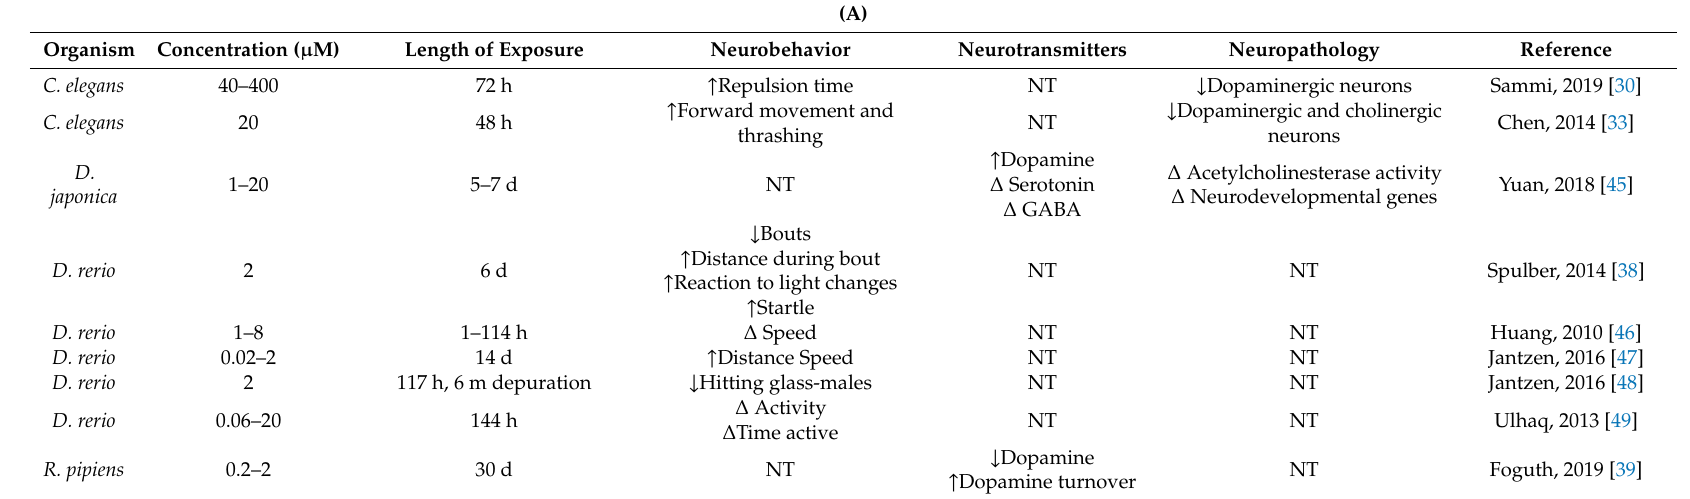
Table 2. Neurotoxicity endpoints and findings in species where neurological endpoints were tested. ( A ). PFOS neurotoxicity and findings in species where neurological endpoints were tested ( B ). PFNA neurotoxicity endpoints and findings in species where neurological endpoints were tested. NT = not tested ( C ). PFOA neurotoxicity endpoints and findings in species where neurological endpoints were tested. NT = not tested. ∆ —indicates a change after exposure that is not consistent over dose or time, i.e., nonmonotonic dose